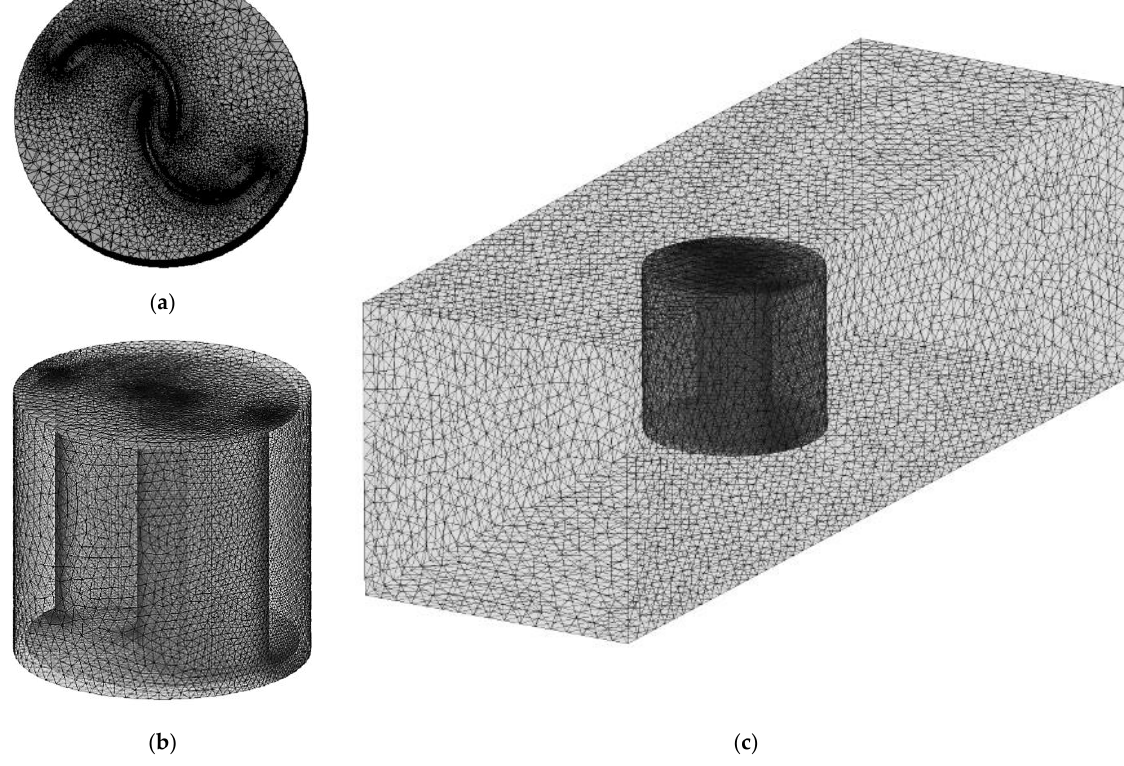
Figure 6. The configuration of the meshes on ( a ) the blades of the turbine, ( b ) the rotating domain, and ( c ) the stationary domain. Table 1. The grid independence statistics for the S-ORM model.